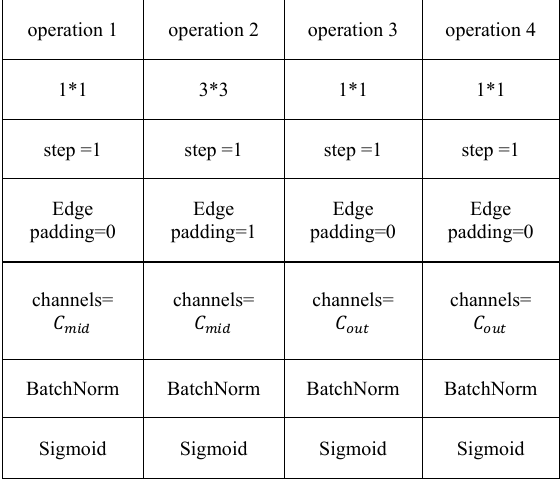
Table 2 . Details of each convolution operation in the convolution